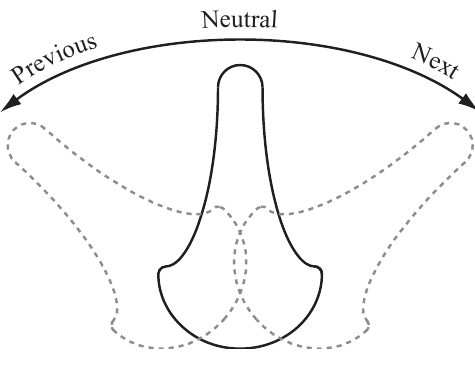
Figure 2. Tilt the collaborative artifacts to go to the previous or next photo.